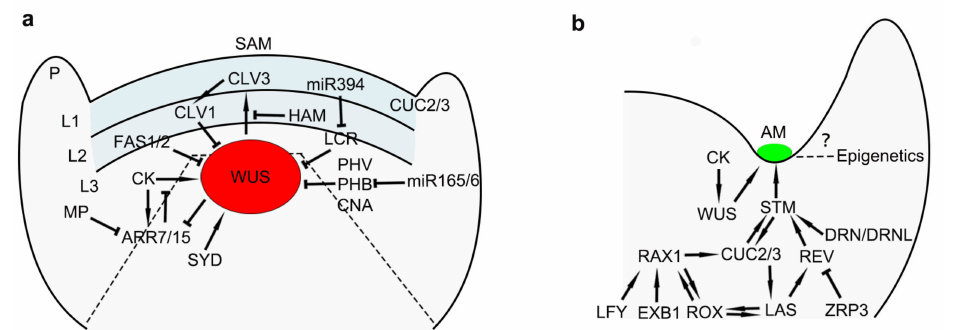
Figure 1. Conceptual models showing regulators in shoot apical meristem (SAM) and axillary meristems (AM) development. ( a ) A diagram illustrates the network in SAM regulation; P: Primordium. ( b ) A model shows factors involved in the regulation of AM development. Arrows and inhibition symbols indicate activation and repression,